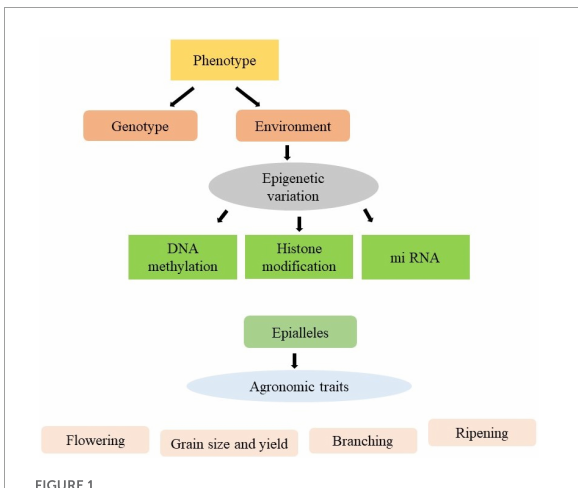
FIGURE1 Use of epialleles for improvement of various agronomical